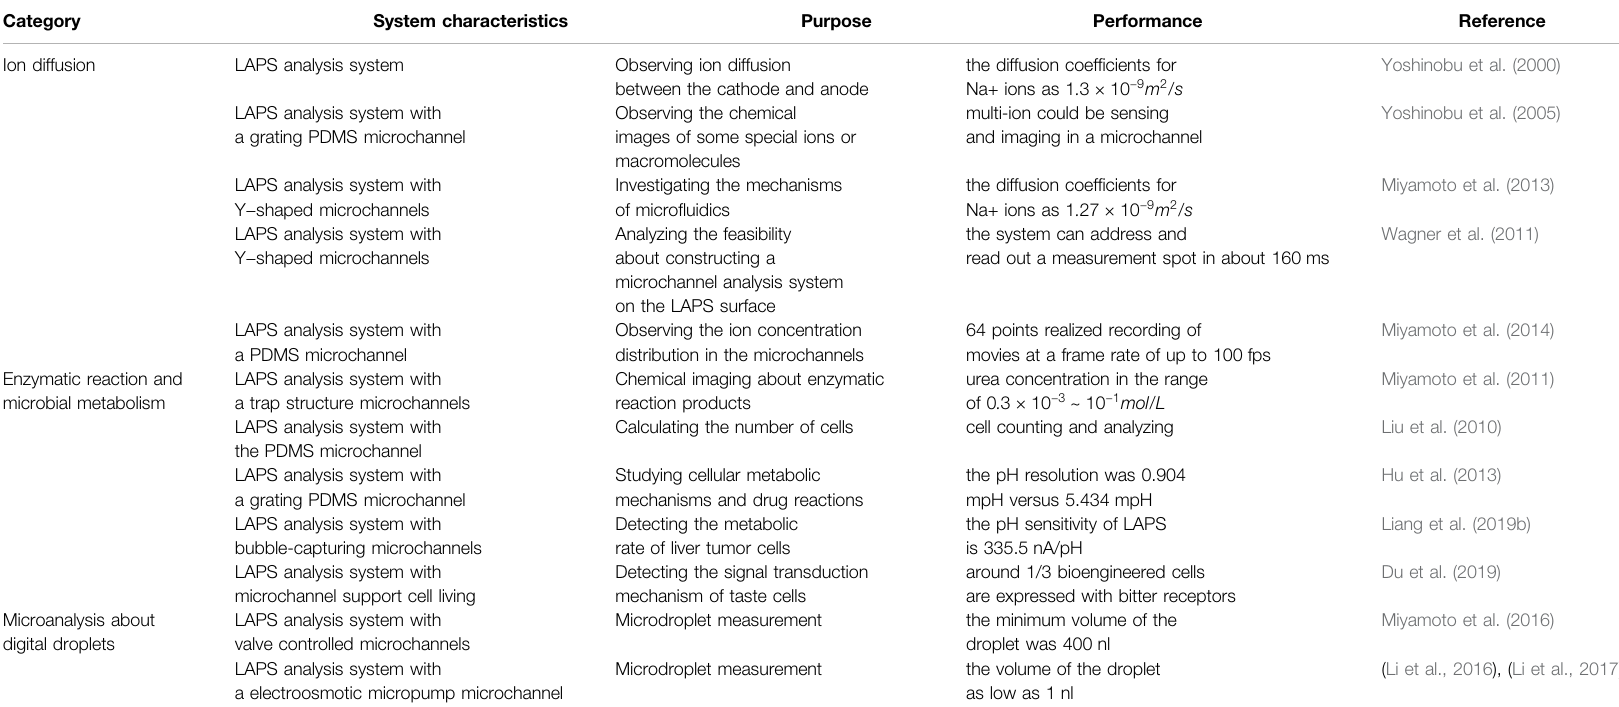
TABLE 1 | Characteristics of the LAPS for a microelectrochemical analysis system with category, system characteristics, purpose, and performance (Selected